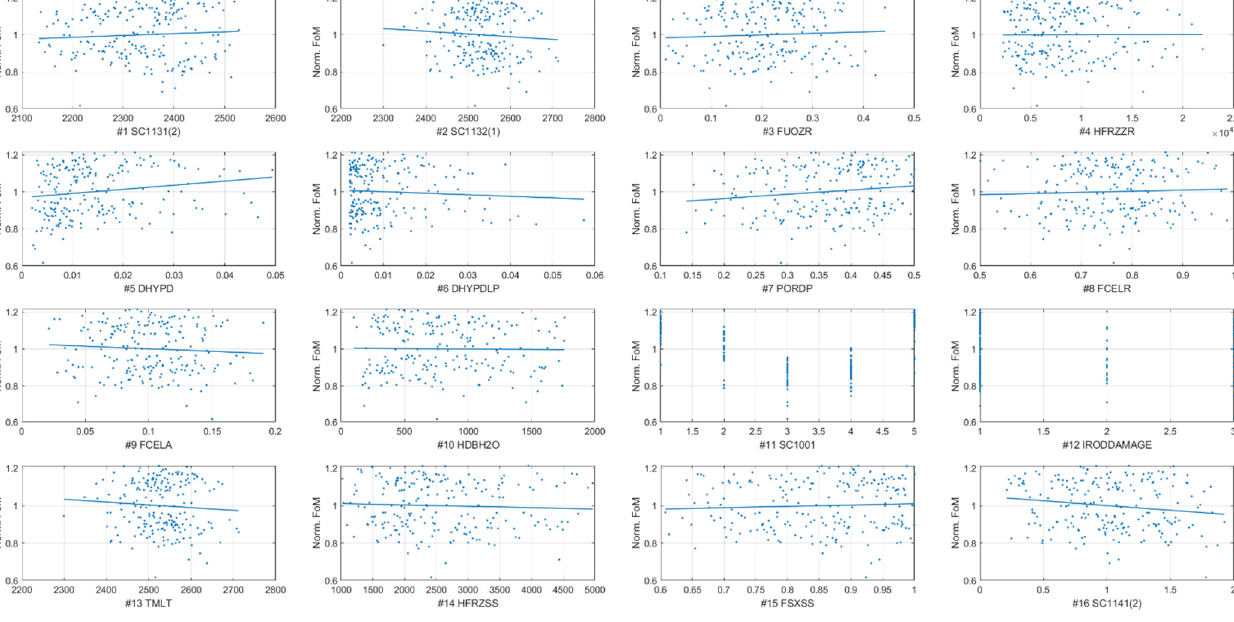
Figure 15. Hydrogen (FoM) mass vs. uncertainty parameters with fitted linear regression for FPT-1. All FoM results are for the final core state. Normalization by the FoM mean value.